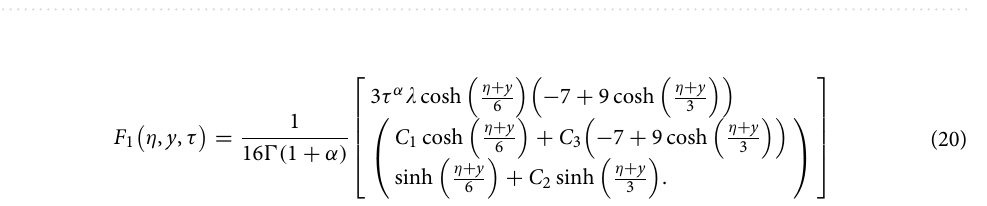
Table 1. Auxiliary convergence control parameters for different values of α for